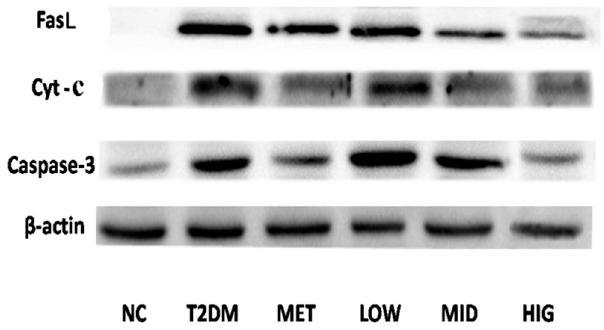
Figure 7. The e ff ect of purified anthraquinone-Glycoside from Rheum palmatum L. (PAGR) on the protein expression of Fas ligand (FasL), cytochrome C (Cyt-c), and Caspase-3 in pancreatic tissue. NC, normal group; T2DM, type 2 diabetes mellitus; Met, metformin group; Low, low group (100mg/kg); Mid, middle group (200mg/kg); Hig, high group (400mg/kg).